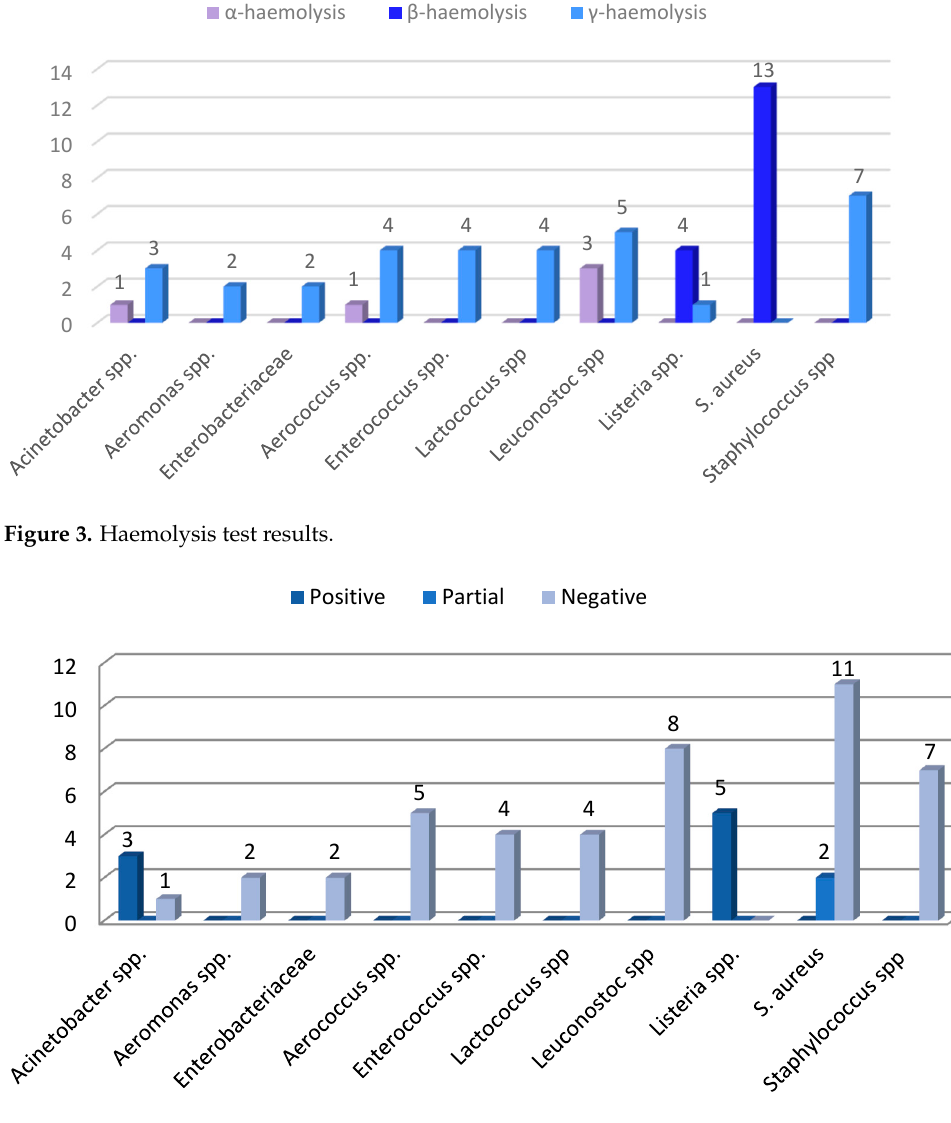
Figure 4. Gelatinase test results.